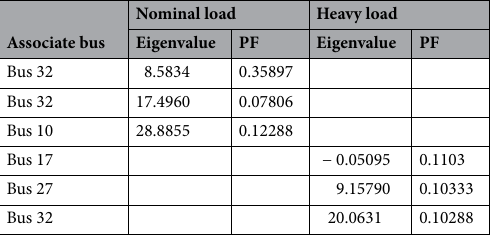
Table 9. Eigenvalue of weakest buses of the system with SPVG PV-model.